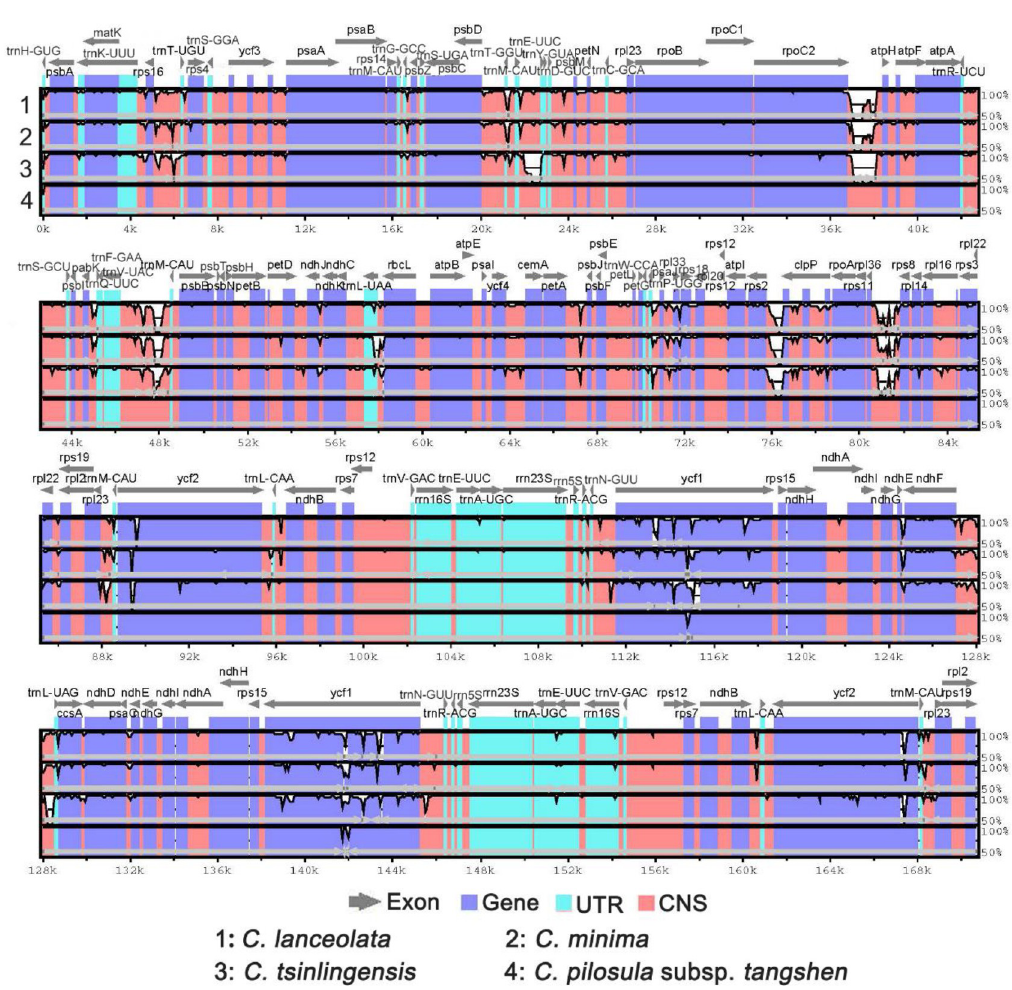
Fig 6. Comparison of the four Codonopsis plastomes by mVISTA. The vertical scale on the right indicates the percentage of identity, ranging from 50 to 100%. The horizontal axis shows the coordinates within the plastome. Gray arrows indicate the genes above the alignments. Different colors represent different regions. The dark blue, light blue, and pink represent exon, tRNAs, or rRNAs and conserved non-coding sequences. The reference is the C . pilosula subsp. tangshen , with its inversion region inverted for comparison. The number code for the species was shown below the